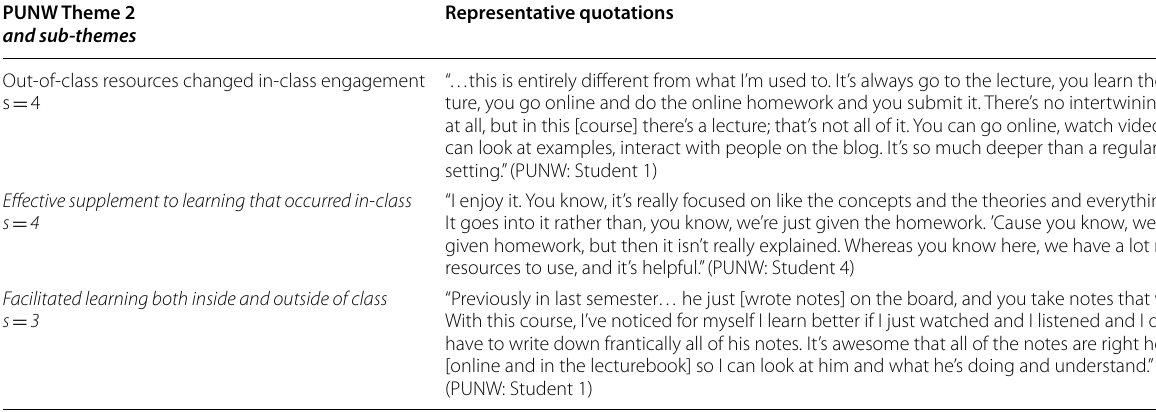
Table 7 PUNW institutional analysis—Theme 2 PUNW Theme 2 and sub-themes